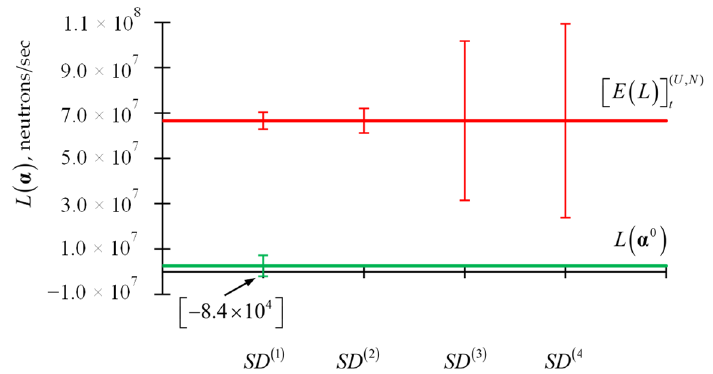
(cid:0) α 0 (cid:1) ± ( U , N ) ± SD ( 1 ) , SD ( 2 ) , SD ( 3 ) , SD ( 4 ) (in red), SD ( 1 ) (in green), [ E ( L )] Figure 2. Comparison of L t Figure 2. Comparison of ( ) ( ) L SD  α 10 (in green), 4 (in red), due due to 10% standard deviations of the uncorrelated microscopic total cross to 10% standard deviations of the uncorrelated microscopic total cross sections.